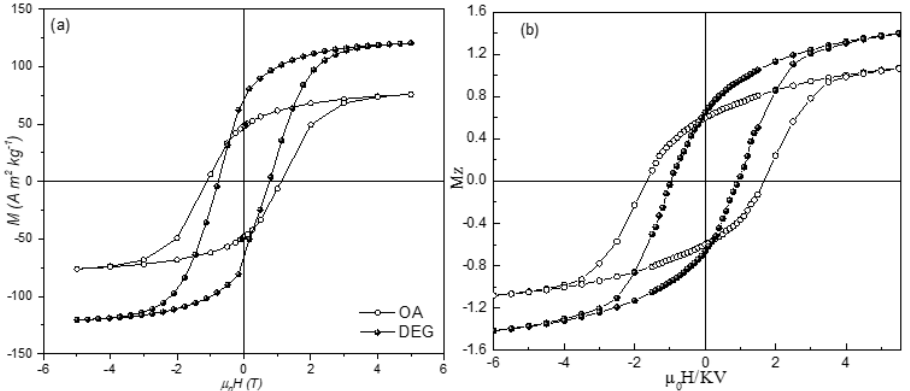
Figure 3. Experimental findings ( a ) and Monte Carlo simulation ( b ) for the hysteresis loops at 5 K for an assembly of interacting CoFe 2 O 4 nanoparticles coated with DEG (full circles) and OA (empty circles) surfactants. The Figure is reprinted with permission from Vasilakaki et al.